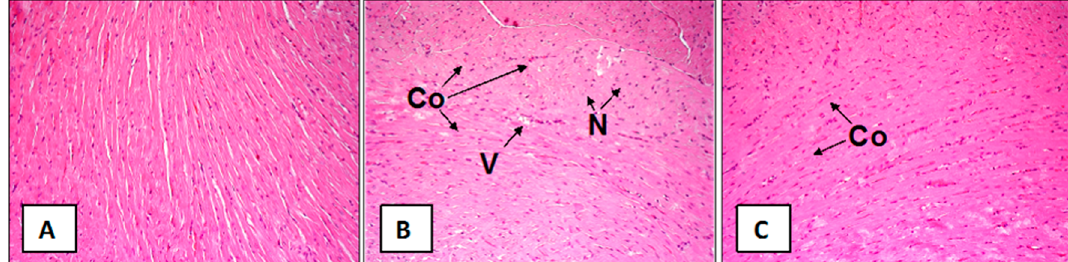
Figure 4. Representative images of the histologic evaluation of heart sections of animals from the control ( A ), Dox ( B ), and HFt-MP-PAS40-Dox ( C ) groups. A normal heart morphology is observed in ( A ). Diffuse blood congestion (Co), cytoplasmic myocyte vacuolization (V), and size variation in myocyte nuclei (N) are present in ( B ), whereas ( C ) shows only a light blood congestion (Co).